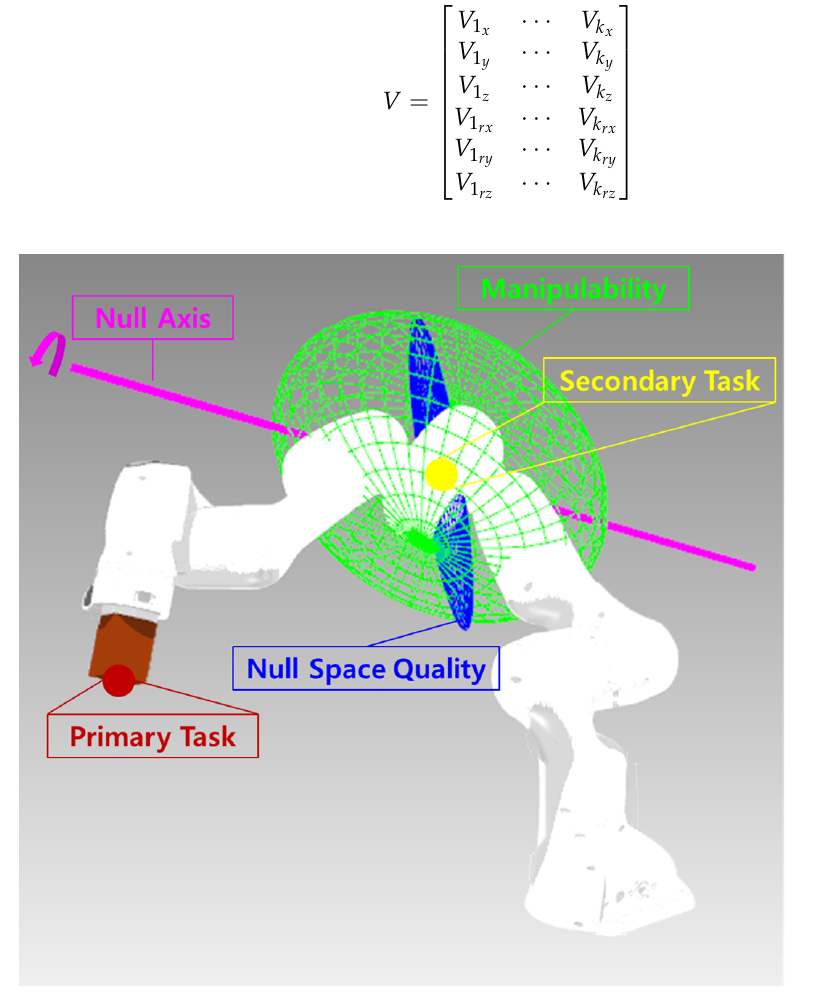
Figure 2. The comparison between the manipulability ellipsoid and the null space quality ellipsoid are shown in green and blue, respectively. The null space quality ellipsoid is displayed while controlling 3-DoF (x, y, and z) at the end-effector as a primary task. The controllable ellipsoid of the secondary task is changed from the manipulability ellipsoid to the null space quality ellipsoid by the null space projection. Furthermore, a 1-DoF of the null axis is shown in